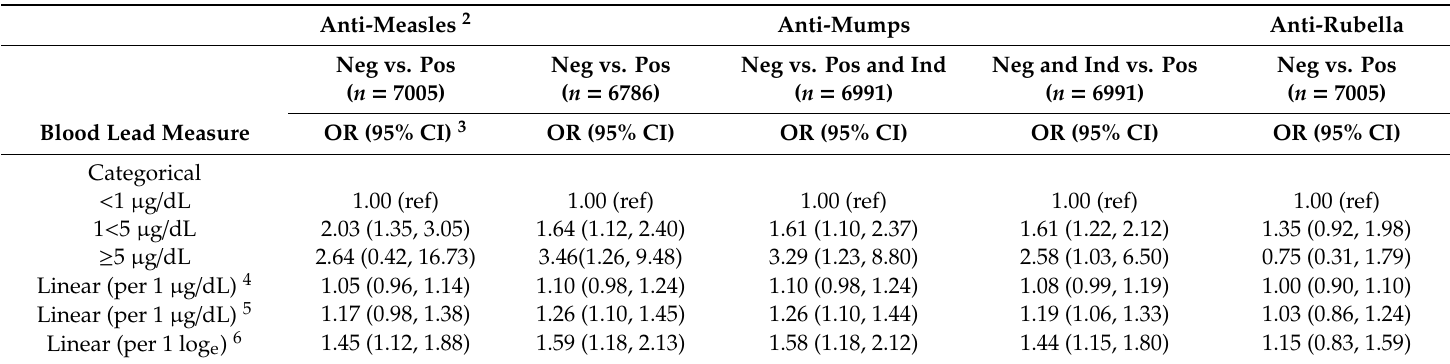
Table 3. Adjusted 1 odds of a negative versus positive anti-measles, anti-mumps, and anti-rubella level in relation to child blood lead